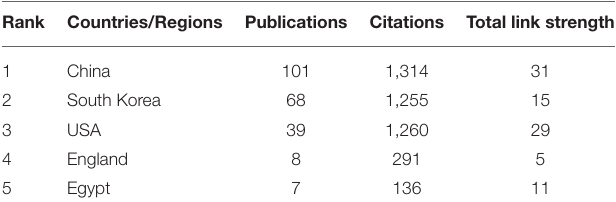
TABLE 1 | Top 5 countries/regions for publications of acupuncture for Parkinson’s disease (PD).